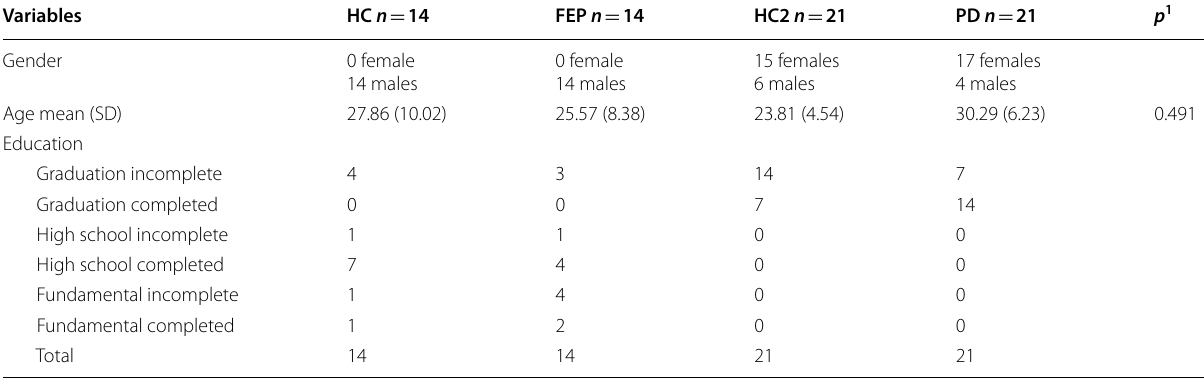
Table 1 Group characteristics from FEP vs HC and PD vs HC2